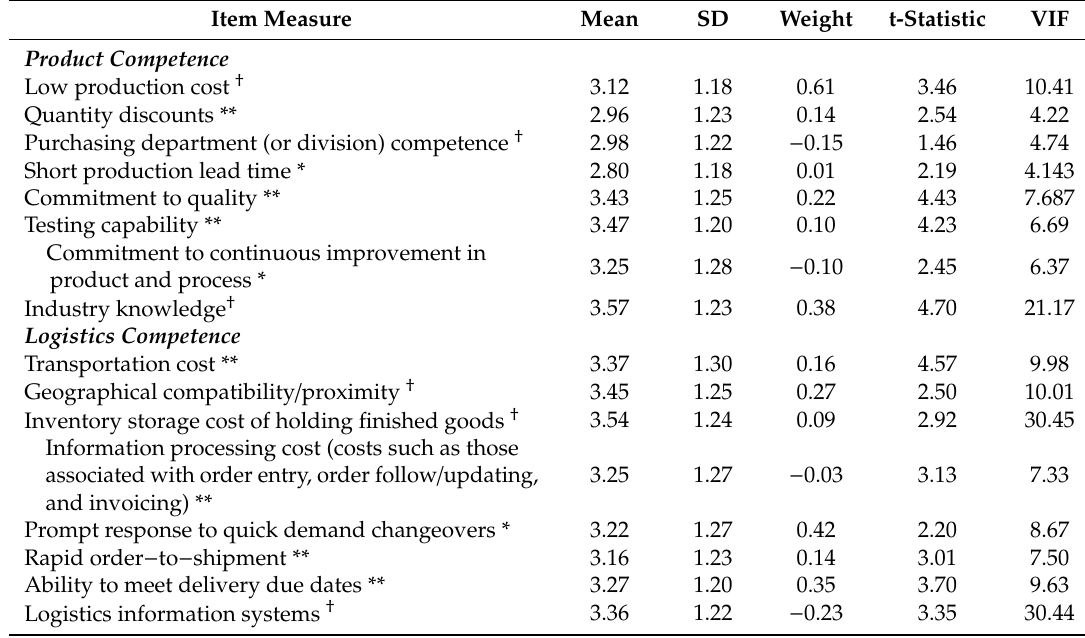
Table 2. Properties of measurement model for formative constructs.